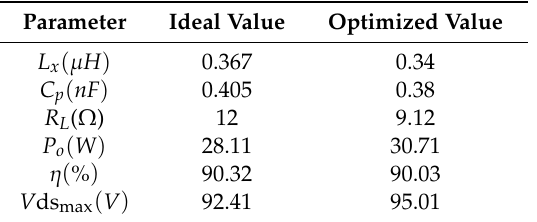
Table 2. Parameter values of RFC before and after optimization.